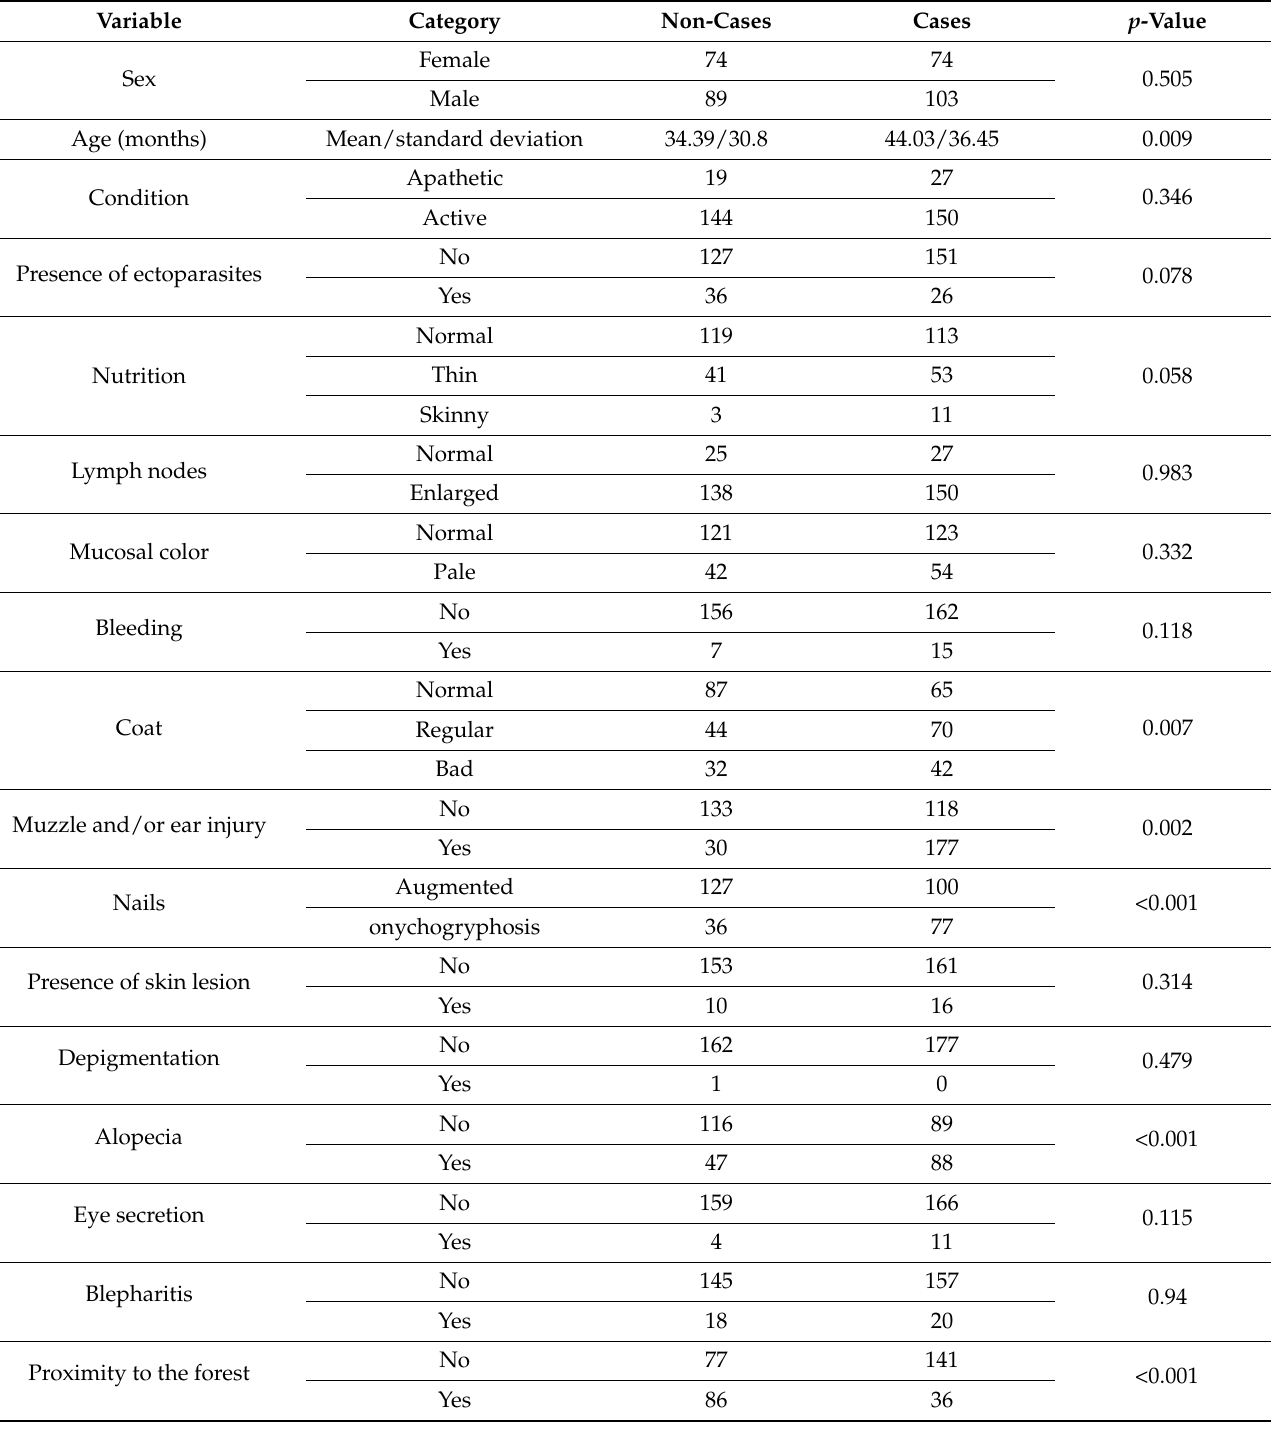
Table 1. Descriptive statistics and univariable associations of features included in machine learning prediction of the canine visceral leishmaniasis (cases: n = 177; non-cases: n =